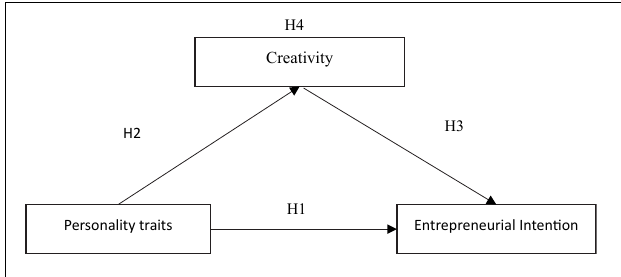
FIGURE 1 | Research